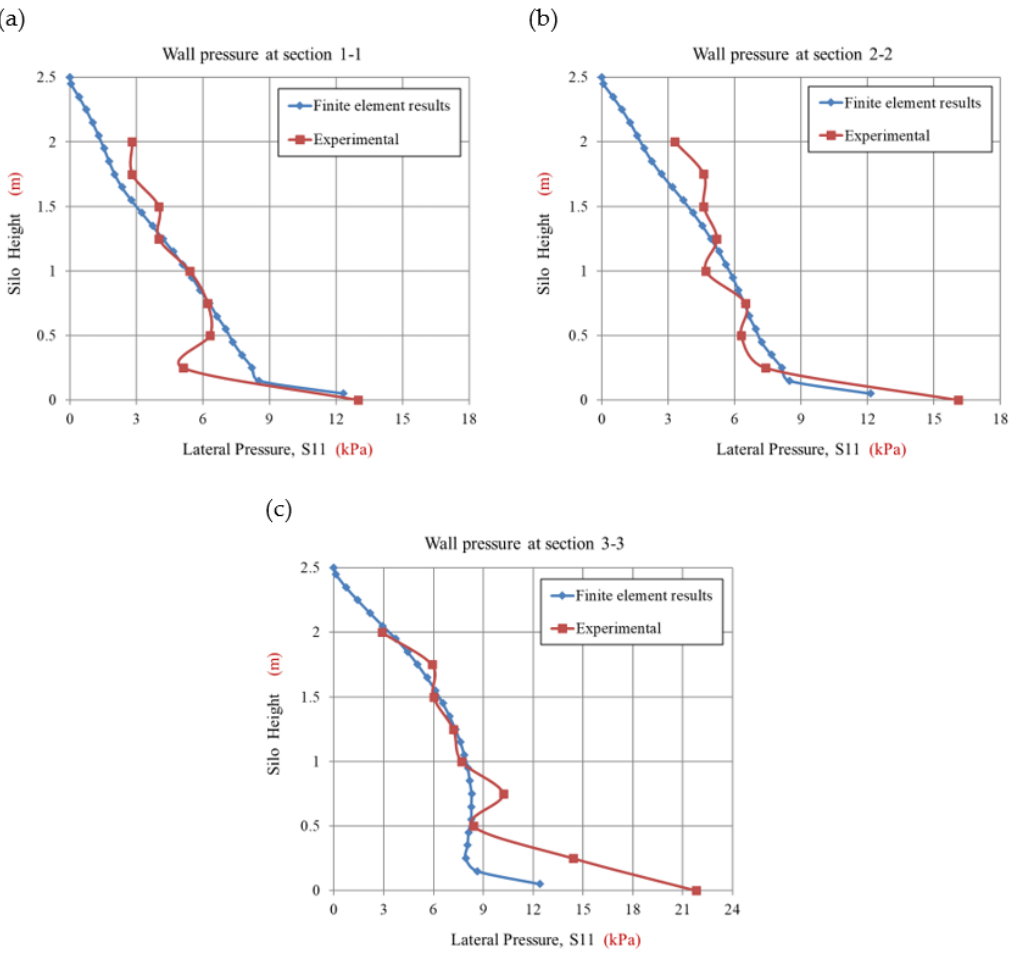
Figure 8. Comparison between lateral filling pressure of the finite element and experimental work along the silo height in the case of the flexible walled silo. ( a ) section 1-1: at mid-side of the wall; ( b ) section 2-2: at 0.35 m from silo center; ( c ) section 3-3: at 0.55 m from silo center.